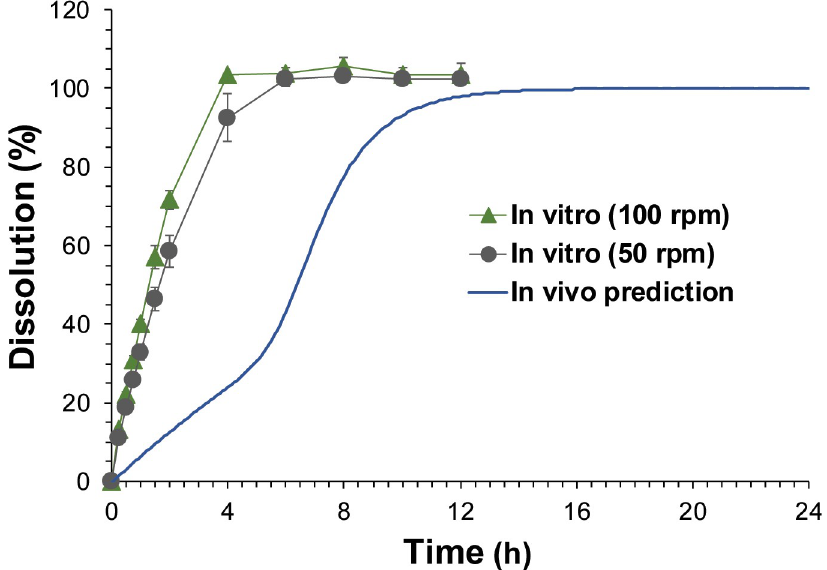
Fig 7. In vivo dissolution profiles of acyclovir gastroretentive (GR) system predicted by the population pharmacokinetic (POP-PK) model. The POP-PK model-predicted and observed dissolution profiles of acyclovir GR system. Symbols represent in vitro dissolution profile obtained by the paddle method with the paddle stirring speed at 50 and 100 rpm, and the solid line represents in vivo prediction obtained by POP-PK model prediction.